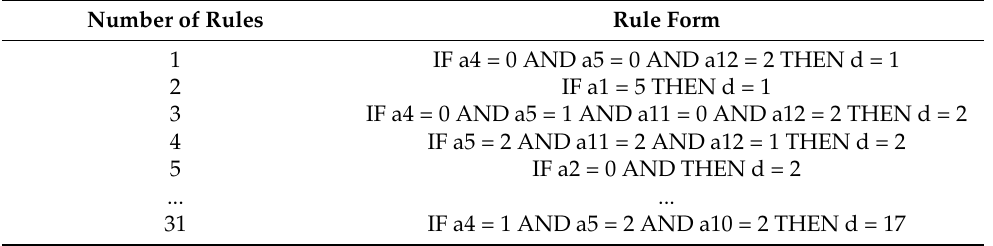
Table 9. Rules set for ship coating